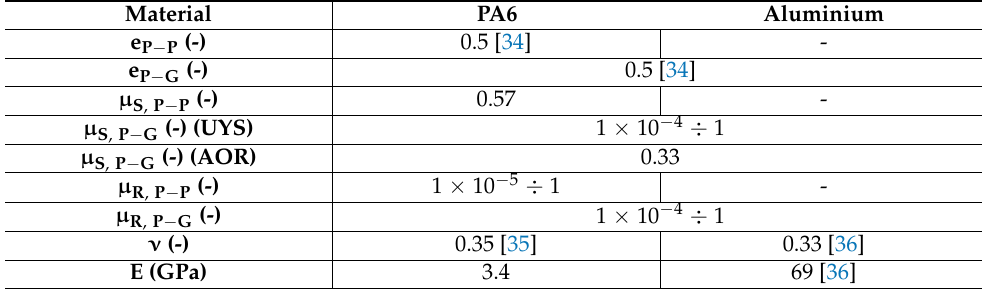
Table 2. Properties inserted in the EDEM ™ model for the interaction between the particles (PA6) and between the particles and the geometries made of aluminium: e P − P and e P − G are the coefficients of restitution between the particles and between the particles and the geometry, respectively; µ S, P − P and µ S, P − G are the coefficient of sliding friction between the particles and between the particles and the geometry, respectively; µ R, P − P and µ R, P − G are the coefficient of rolling friction between the particles and between the particles and the geometry, respectively; ν is the Poisson’s ratio; E is the Young’s modulus. Values with references were taken from the literature, while the others were taken from the technical data sheet of the powder or directly measured as described in the text. Regarding µ S, P − G there are two rows: the first reports the values of µ S, P − G used in the unconfined yield strength (UYS) calibration; the second reports the value of µ S, P − G used in the static angle of repose (AOR) calibration, and which has been measured as described in the